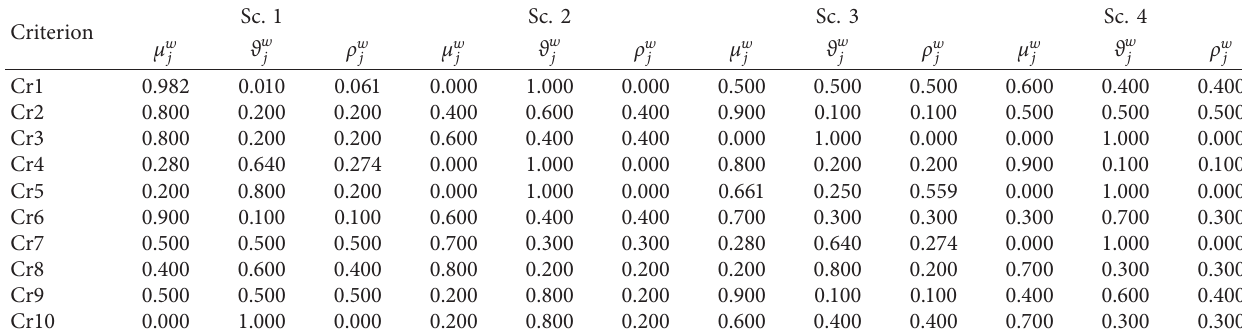
Table 6: Criteria weights used in the sensitivity analysis scenarios.